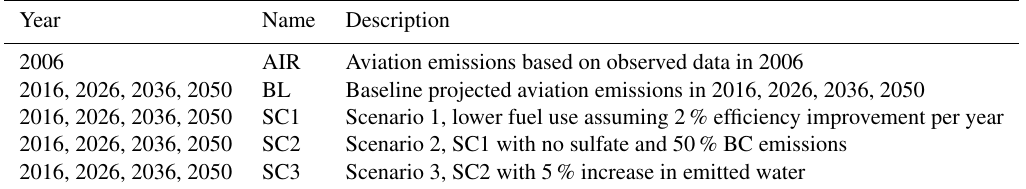
Table 1. Various aviation emission scenarios based on Barrett et al.